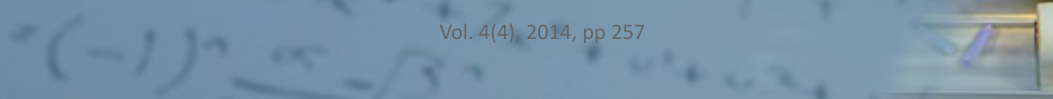
Vol. 4(4), 2014, pp